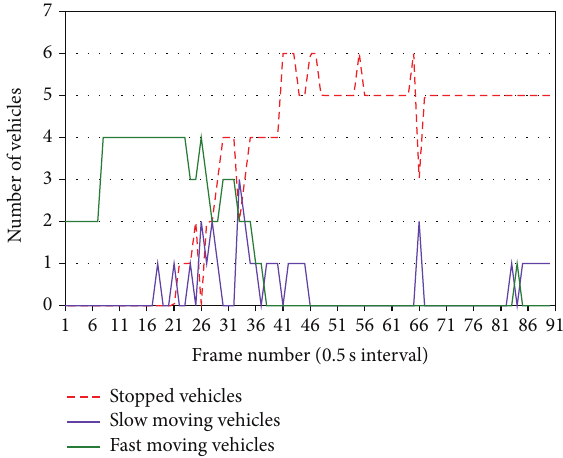
Figure 16: Fluctuations of the number of vehicles in two center- lanes.